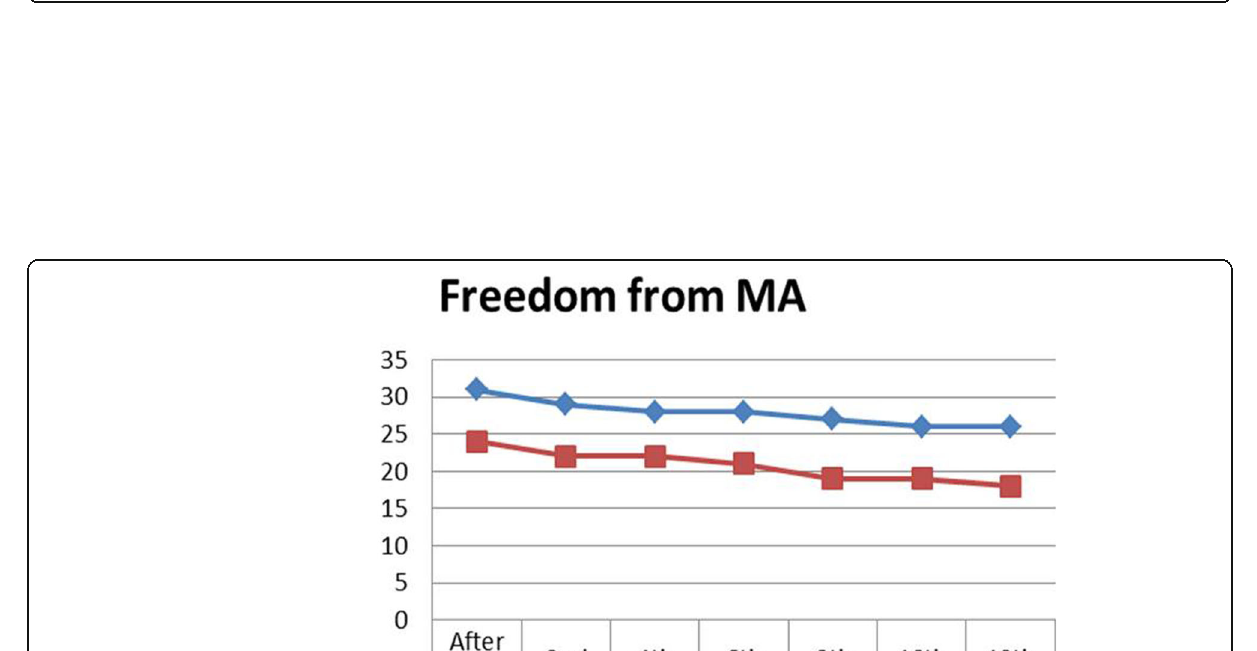
Fig. 2 Curves showing freedom from major adverse limb events between direct and indirect groups